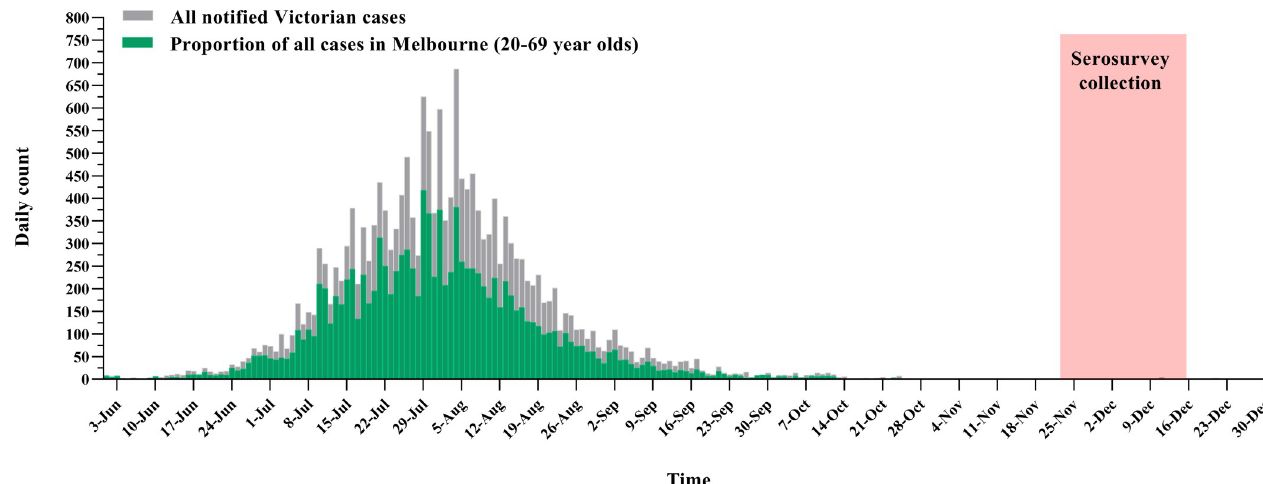
Fig 1. Count of COVID-19 case notifications between 1 June and 31 December 2020 in Victoria overall (grey bars) and among residents of metropolitan Melbourne aged 20–69 years (green bars), and timing of specimen collection.